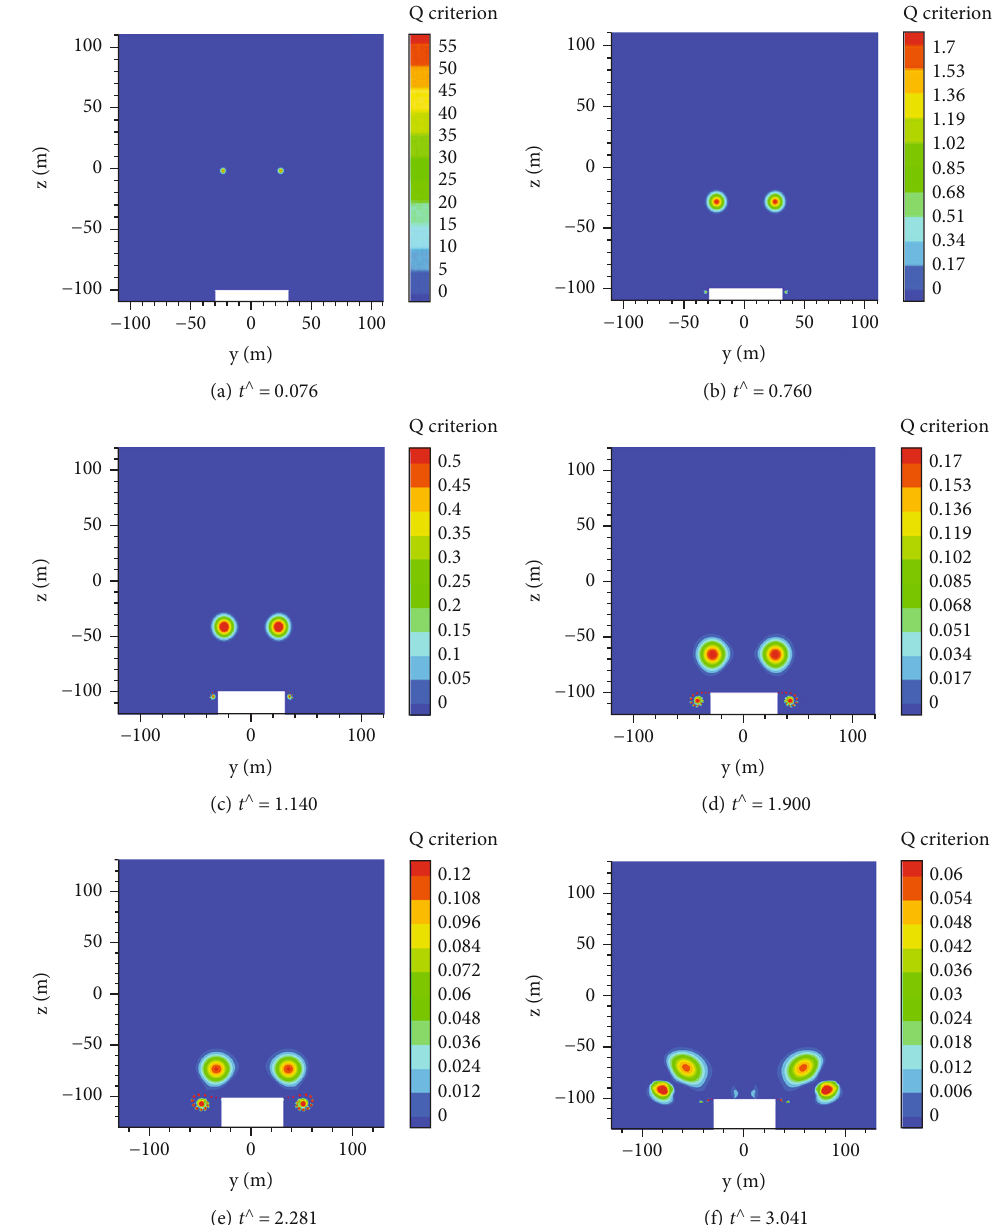
Figure 15: Contours of Q criterion at di ff erent times when the wake is 100 m above the